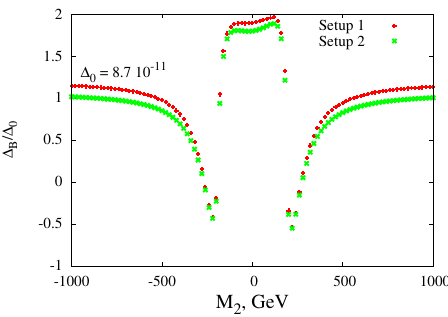
Figure 4 . Plot of (cid:1) B = (cid:1) 0 versus gaugino mass parameter M 2 for the parameter sets presented in tables 1 and 2.